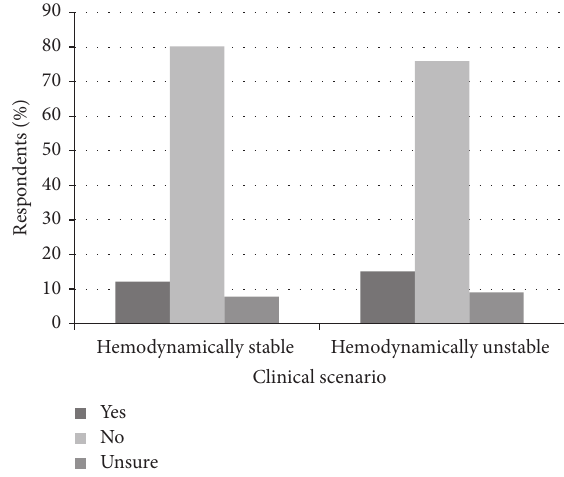
Figure 3: Are clinicians transfusing patients with UGIB on novel anticoagulants more liberally than patients on warfarin?